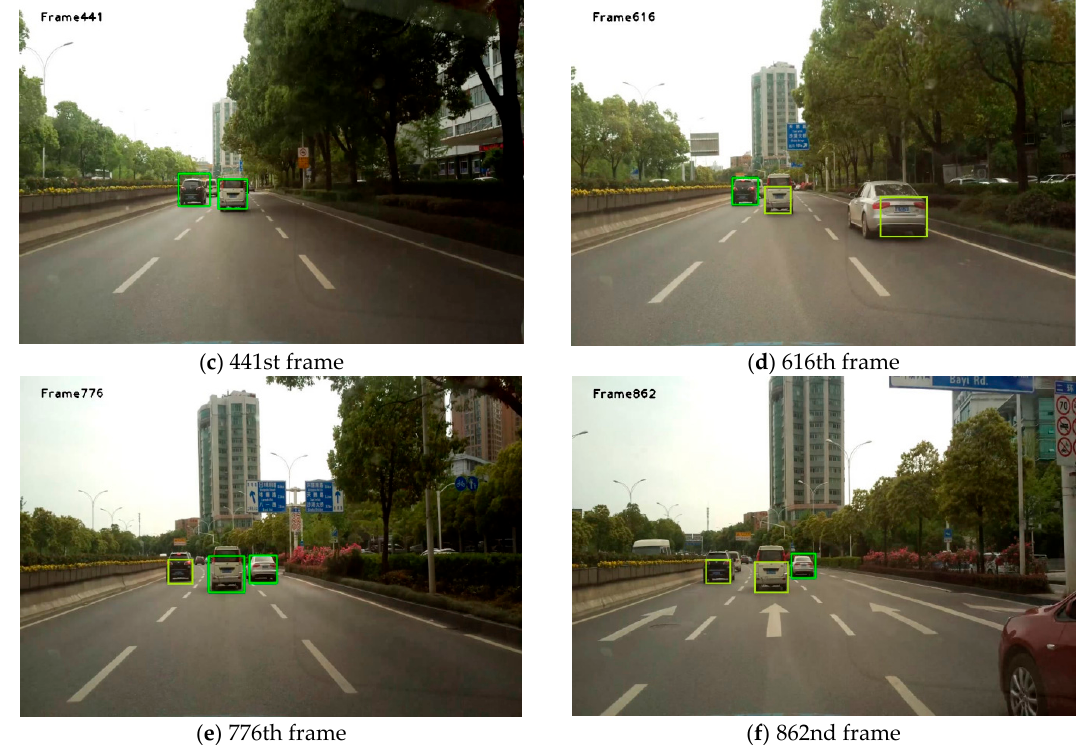
Figure 9. Part of the front-vehicle detection results in Video 2.